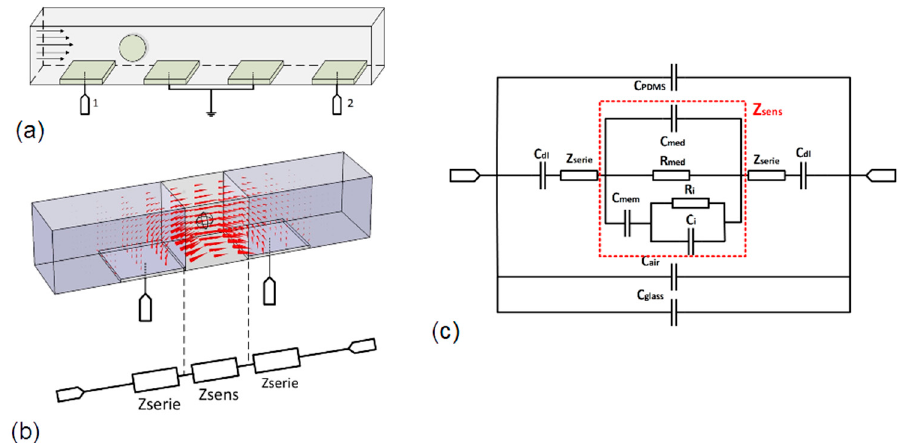
Figure 2. ( a ) Schematic of the microchannel sensing area, ( b ) schematic of current flow in the sensing area and equivalent electric model, and ( c ) equivalent electric circuit of cytometry microsensor with sample.